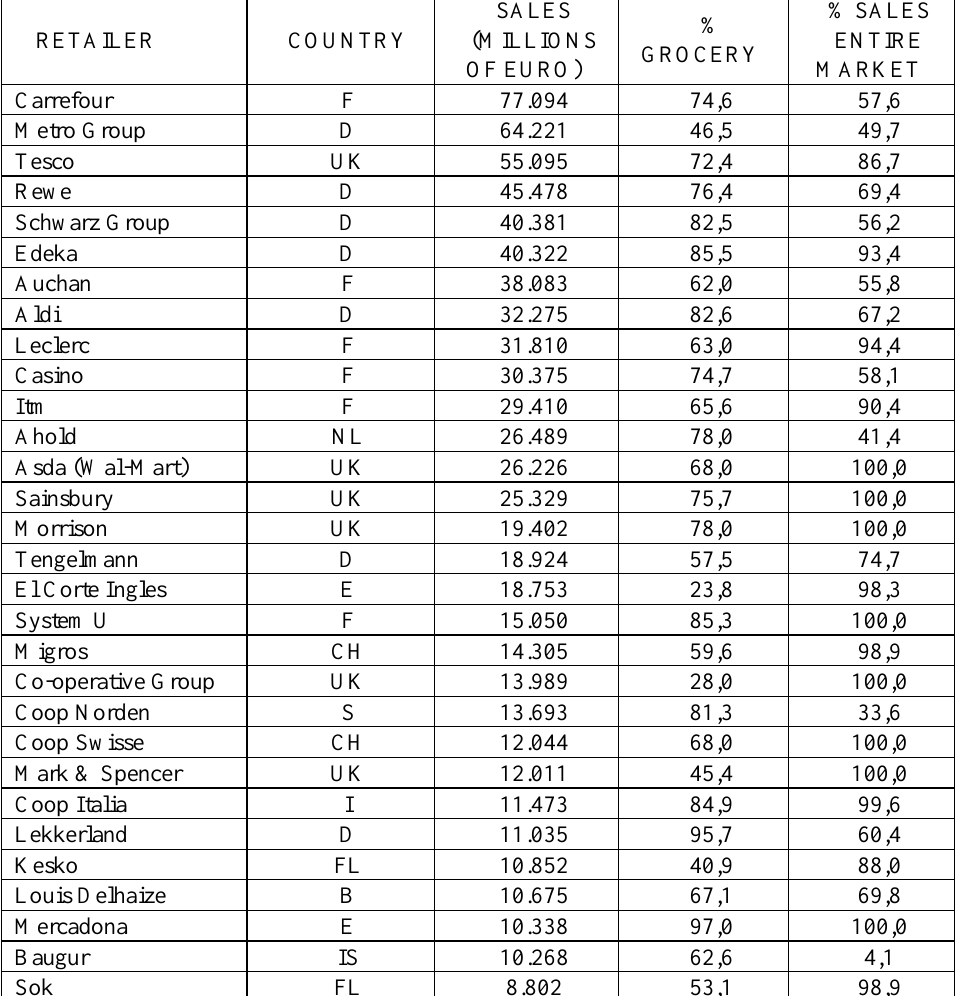
SALES % SALES % (MILLIONS ENTIRE GROCERY OF EURO) MARKET